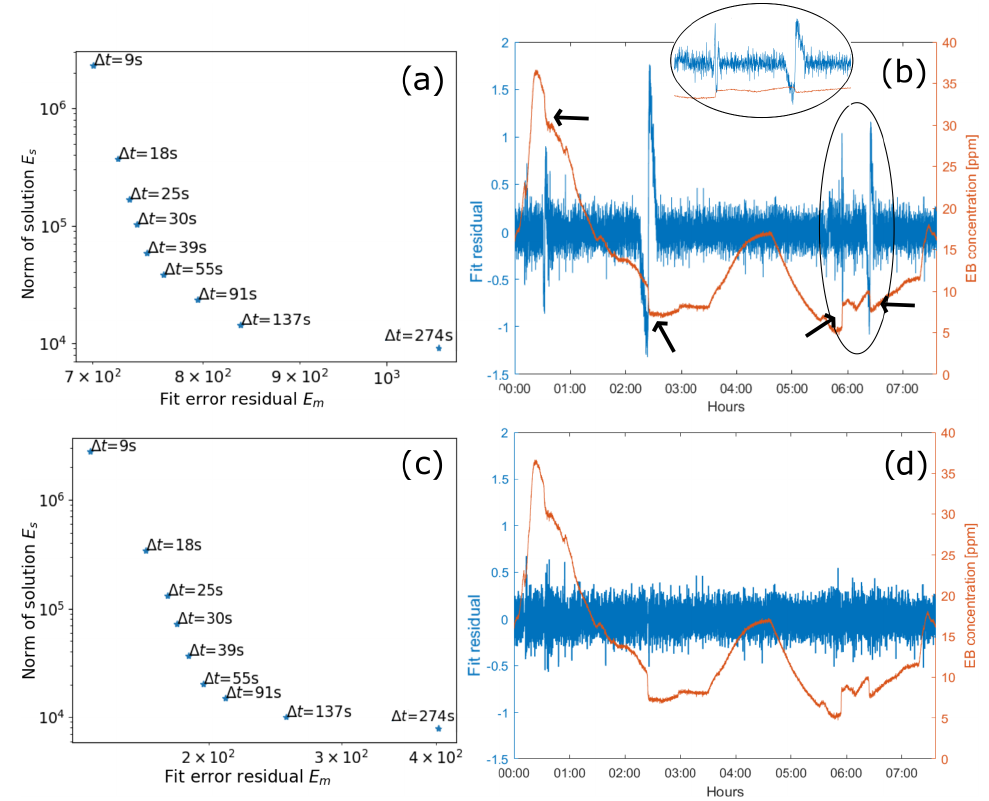
Figure 5. (a) L curve for sweep of different (cid:49)t values for estimated RT-corrected EB sensor data. The y axis, E s , is the noise in the data given by the step difference between adjacent data points, which is high for models that are too complex (lower (cid:49)t/ higher number of data ) − m j , which shows how well the best fit model explains the measurements. points) in the model. The x axis is the fit error residual, ˆ u m (t (cid:48) j ) − m j (blue line) for each point in measurement time using (cid:49)t = 55s and raw EB sensor data (red line). Residual (b) Fit residuals ˆ u m (t (cid:48) j spikes attributed to a malfunctioning of the EB sensor are indicated by the black arrows (and zoom in oval inlet). Panels (c) and (d) show the results from the same analysis as (a) and (b) , but on the dataset where the problematic regions defined in (b) were